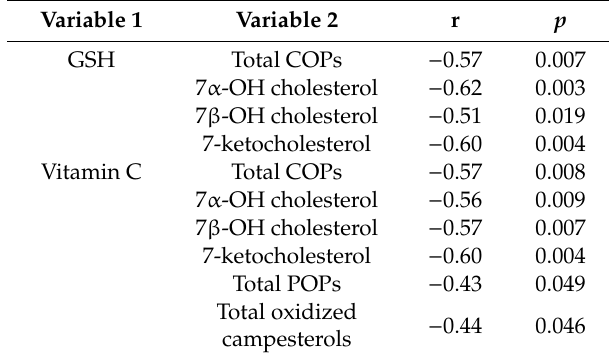
Table 7. Significant correlations between the concentrations of antioxidants (GSH and vitamin C) in thigh muscle and concentrations of cholesterol oxidation products (COPs) and phytosterol oxidation products (POPs) in heat-processed thigh muscle